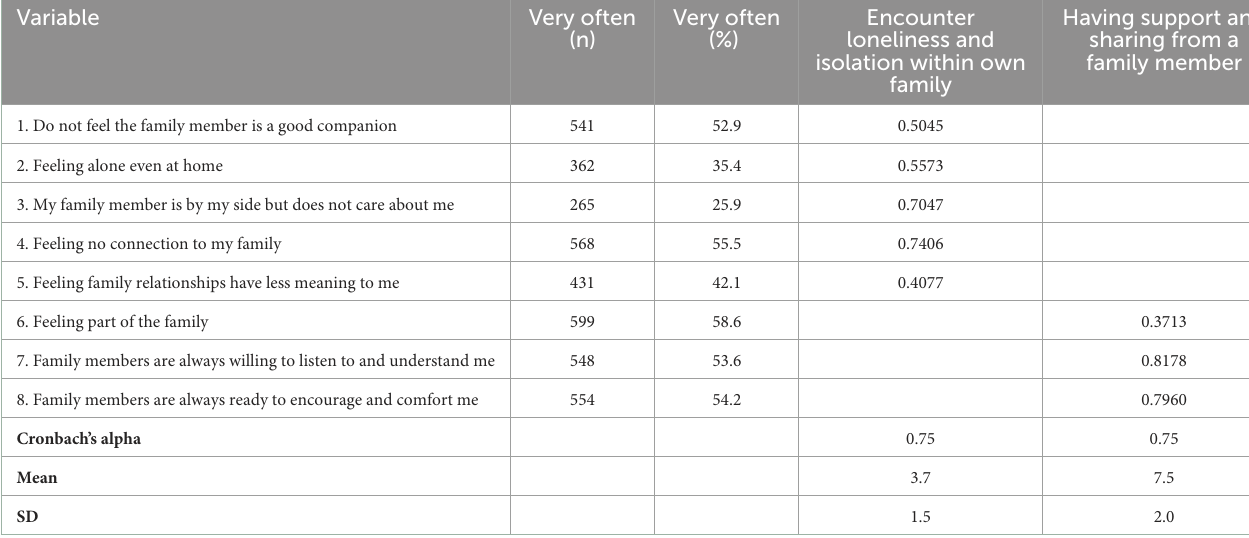
TABLE 2 Factor loadings of student’s feeling at home of participants. Variable